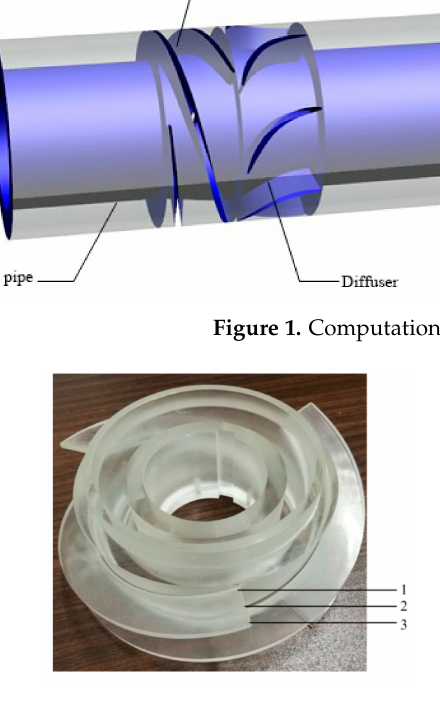
Figure 2. Impeller spans. 1. Hub, 2. 0.5 span, 3.